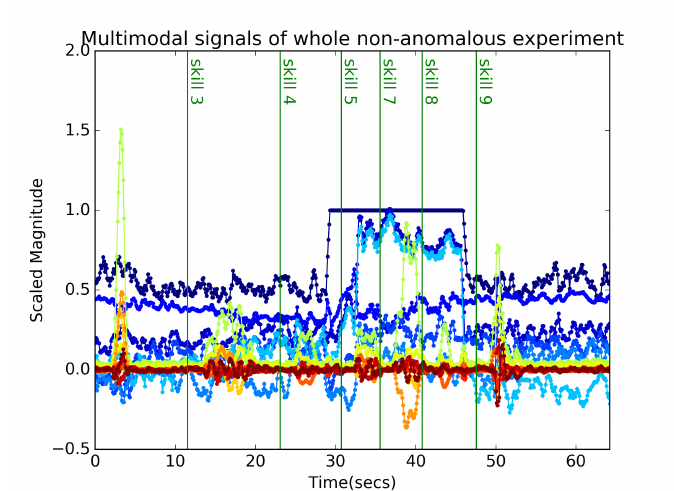
Figure 6. Multimodal signals of a nominal experiment with six